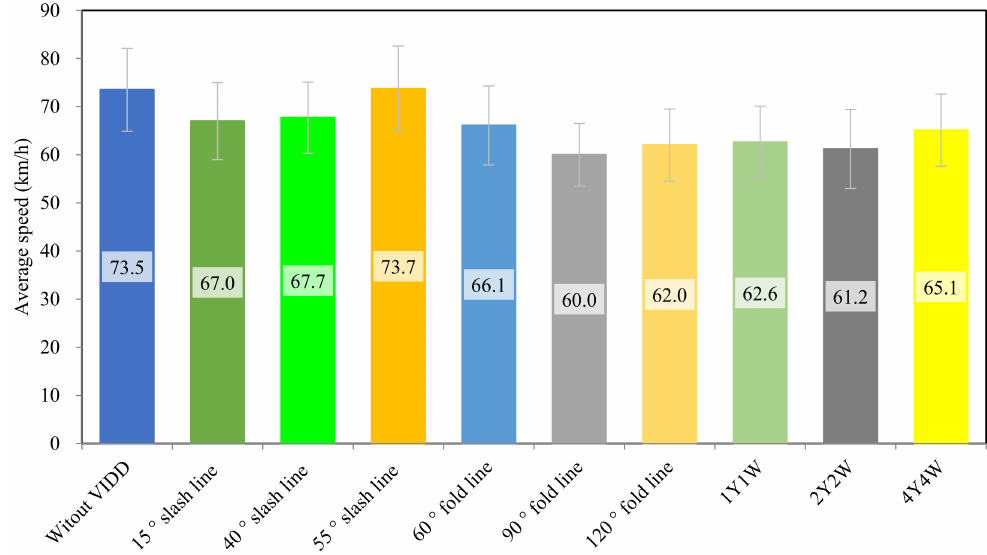
Figure 17. Average speeds and standard deviations of vehicles in middle of tunnel with and without VIDD.